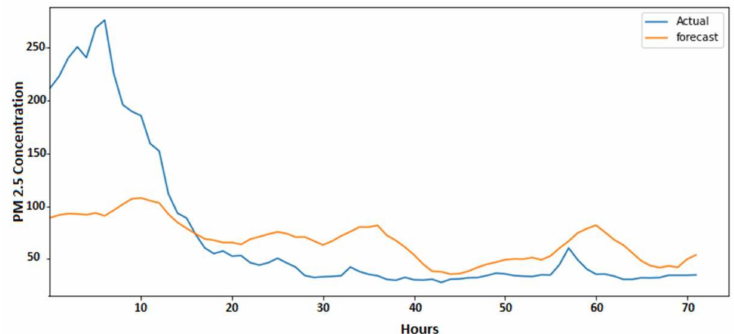
Figure 27. Forecasting for the next 72 h for Karachi using the multivariate FbProphet model.